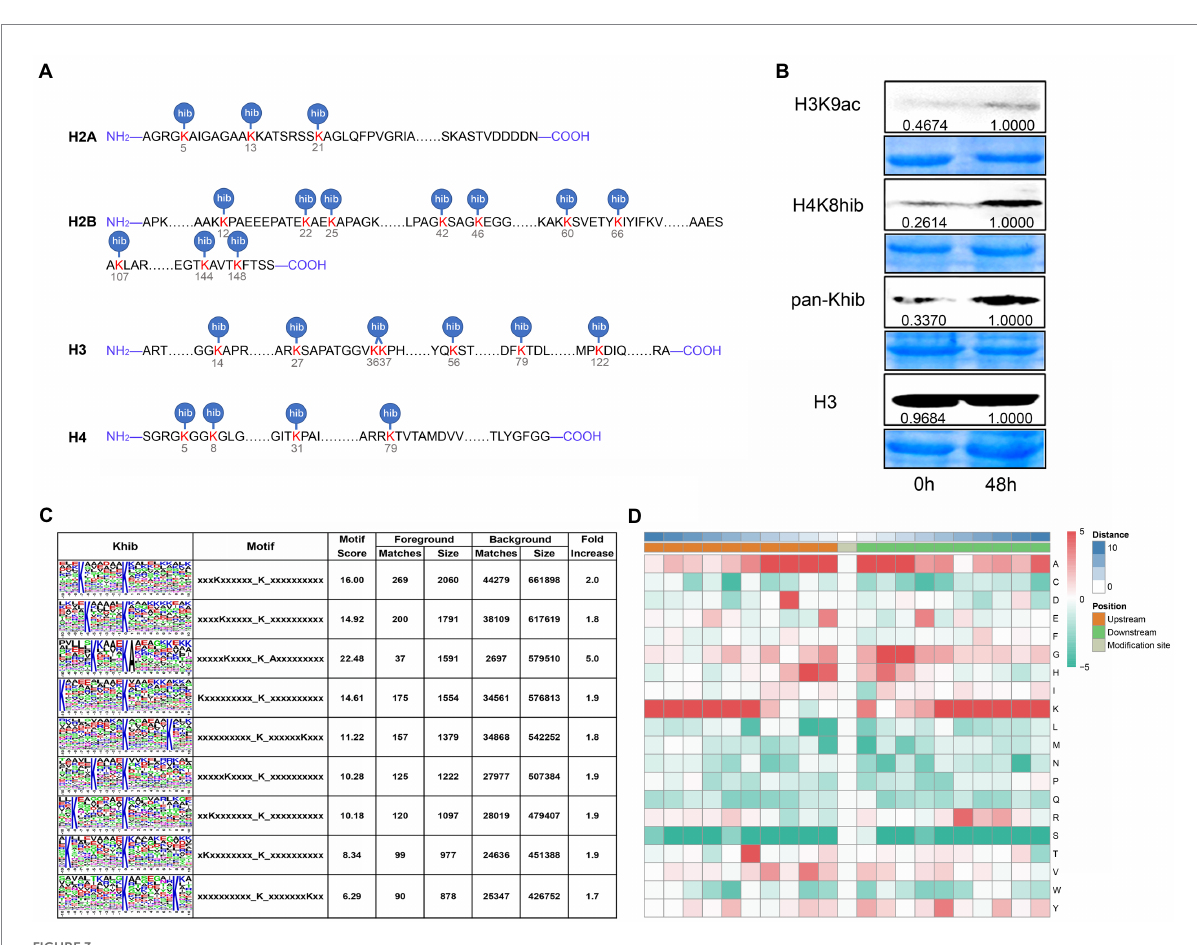
FIGURE 3 Identification of Khib modification sites on histones and Khib motifs. (A) Khib modification sites on histones identified by proteomics data. (B) Immunoblotting analysis of histone protein H3K9ac and Khib levels with histone deacetylase inhibitor (Trichostatin A, TSA) treatment. Histone H3 was used as a loading control. (C) Identification of 2-hydroxybutyrylation motifs by motif-x. The height of each letter corresponds to the frequency of that amino acid residue in that position. (D) Heatmap of the amino acid composition of the Khib modification sites, red and green, respectively, showed the enrichment and reduction of amino acids at each position (right letter) on both sides (from − 10 to +10) of the Khib